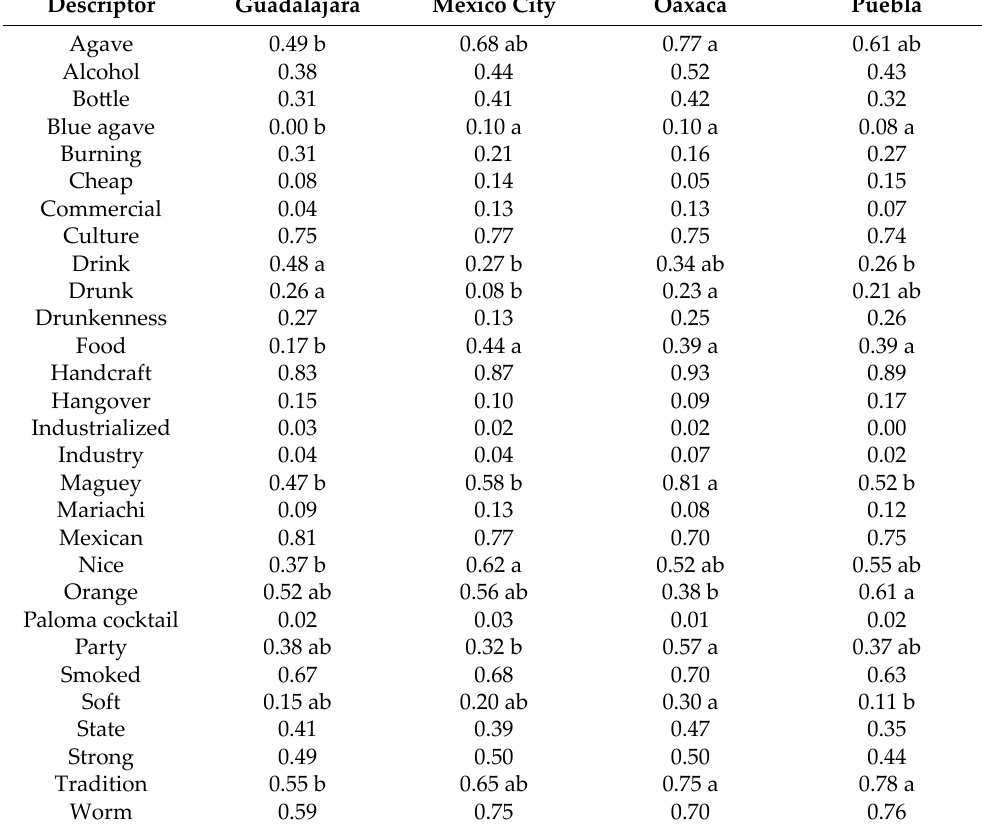
Table 4. Proportions of selected words per city to describe mezcal.